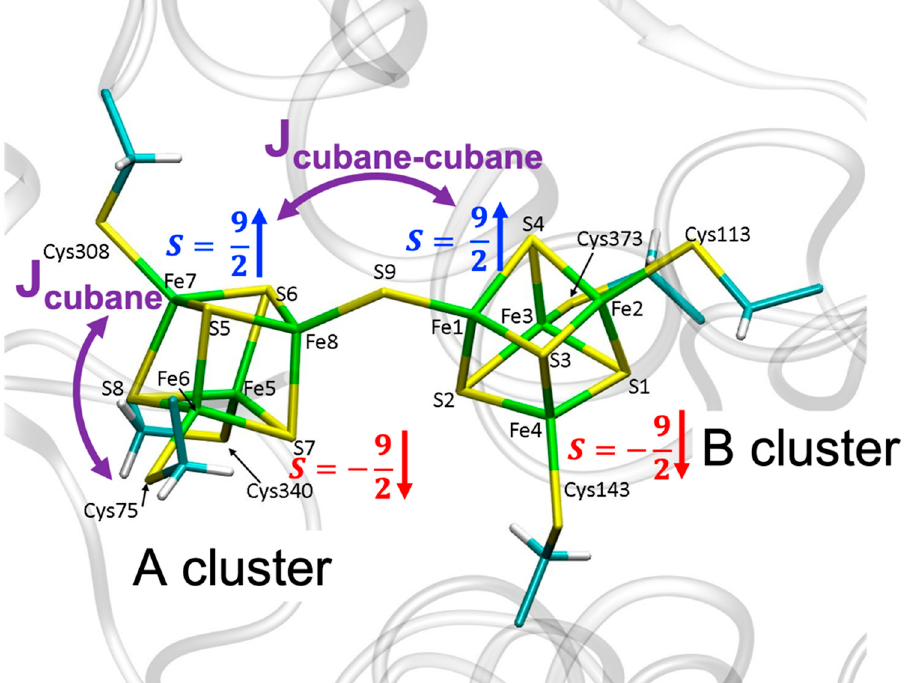
Figure 1. The double ‐ cubane cluster (DCC) of the double ‐ cubane cluster protein (DCCP), from the structure file 6ENO.pdb (1.63 Å) [1], shows the A ‐ cluster coordinated to sidechains of Cys75, Cys308, and Cys340 and the B ‐ cluster coordinated to sidechains of Cys113, Cys143, and Cys373. A ‐ cluster is linked to B ‐ cluster via the μ 2 ‐ S ligand (S9). Each cubane cluster contains an exchange interaction between the mixed ‐ valence Fe dimers within the cubane (J cubane ) (dimer high spin “up” shown in blue; dimer high spin “down” shown in red). An exchange energy also arises from two mixed ‐ valence Fe dimers interacting via the μ 2 ‐ S ligand (J cubane ‐ cubane ).